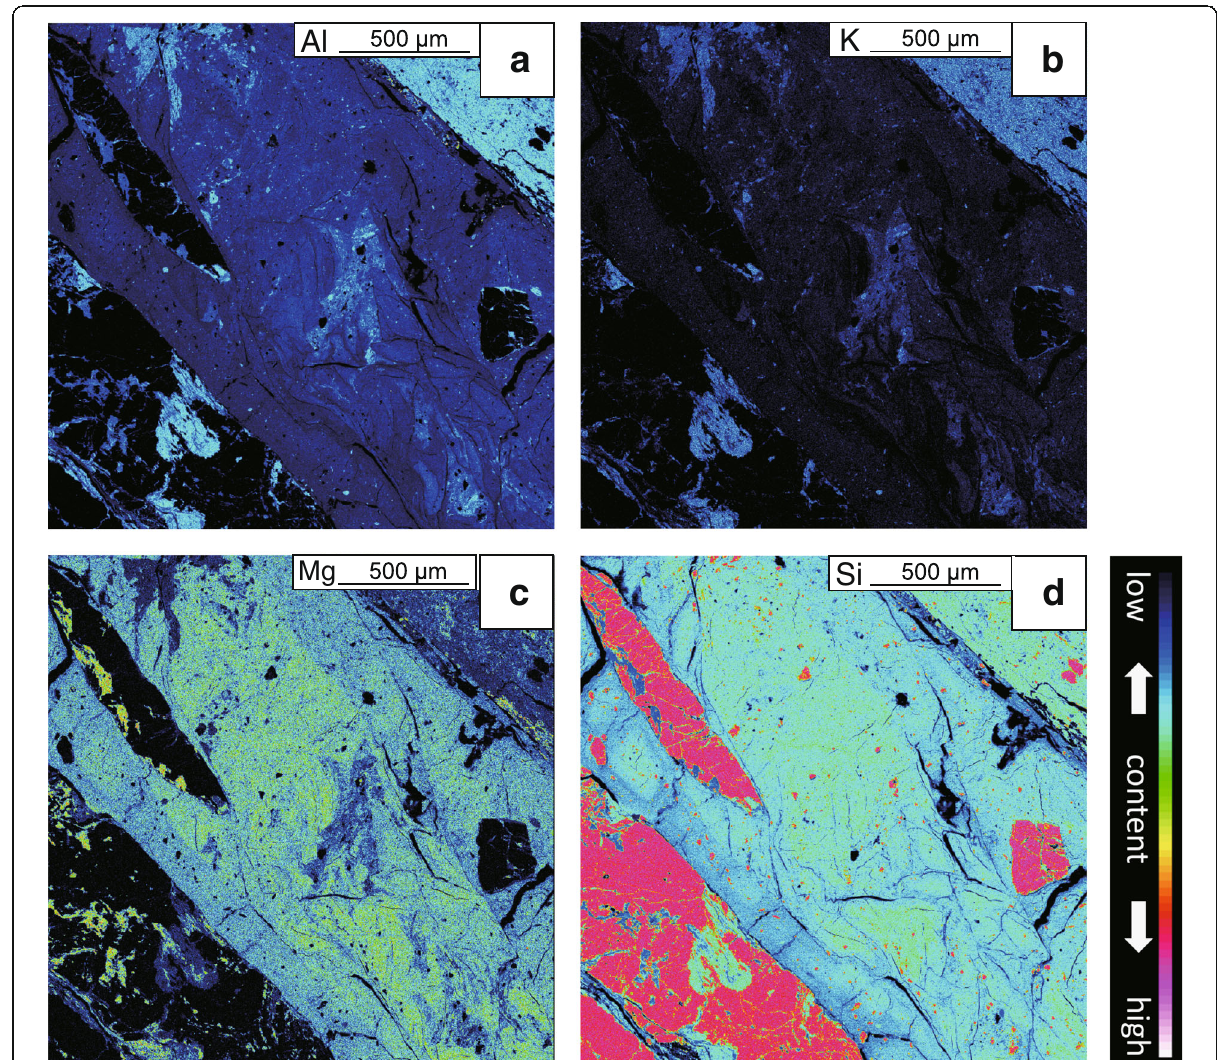
Fig. 6 EPMA element mapping images of a Al, b K, c Mg, and d Si. Analyzed area is shown in Fig. 5b. Al and K show flow texture and residual phyllosilicate particles within matrix, while the Mg distribution is complementary. Red-colored parts of the Si map show the distribution of residual quartz